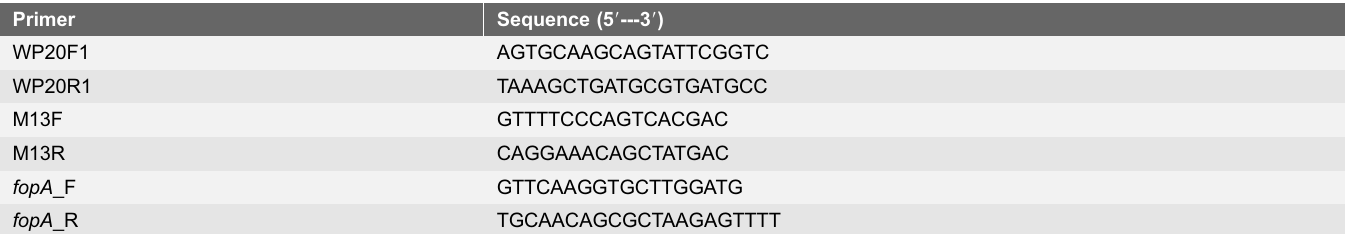
Table 2. Primers used in this